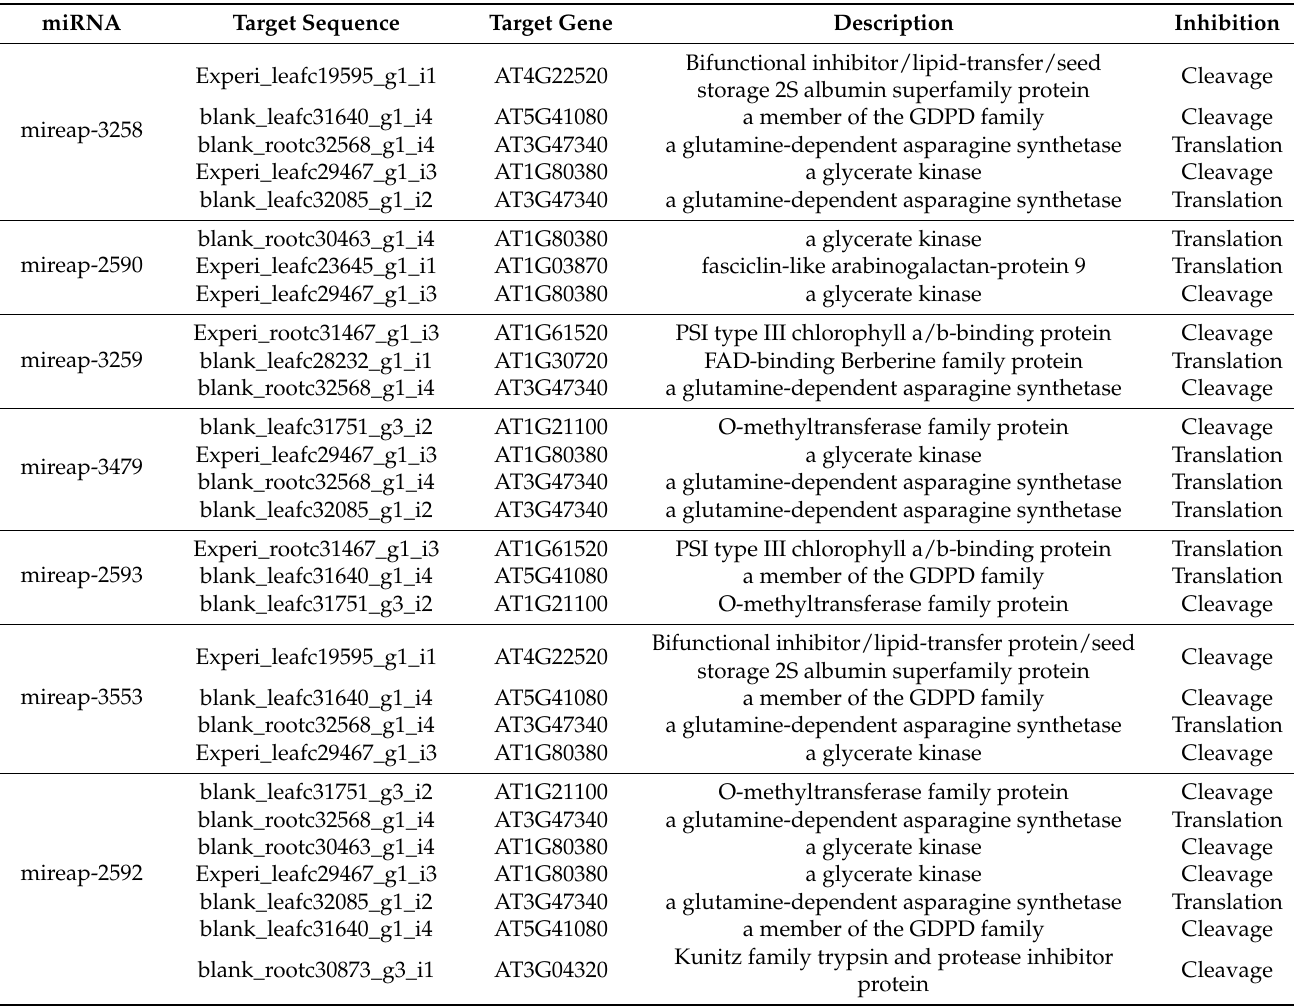
Genes related to the biotic stress pathway are